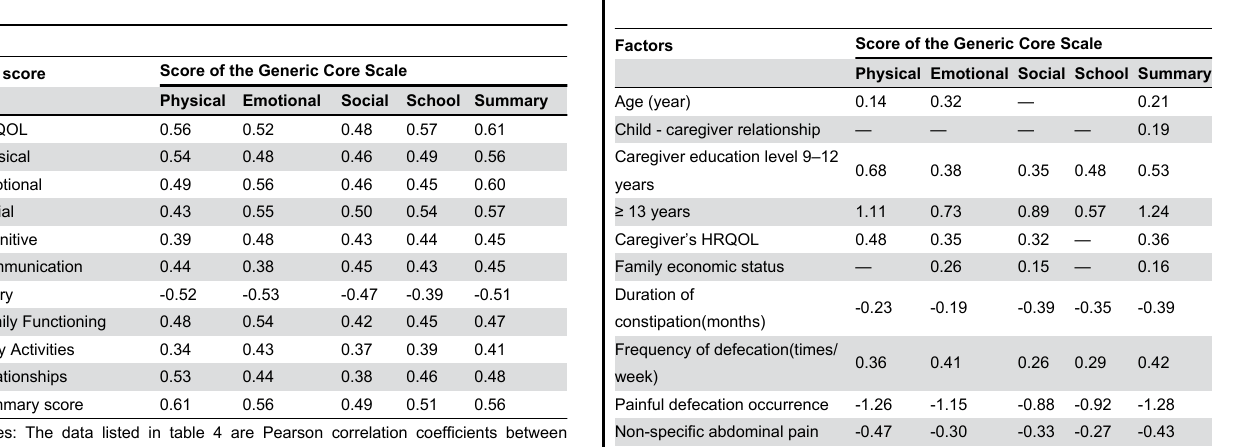
Table 5. Factors influencing HRQOL in children with